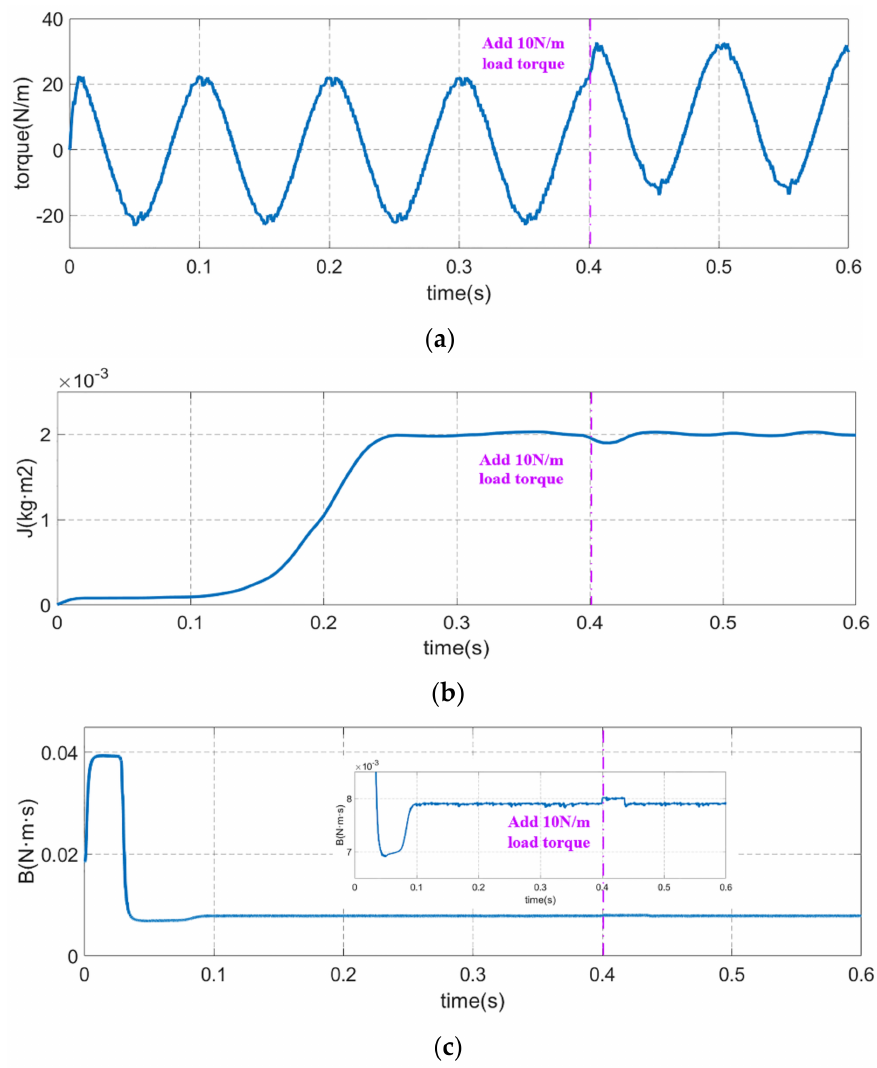
Figure 11. The anti-disturbance performance of the inertia and friction coefficient identification results: ( a ) Motor speed. ( b ) Moment of inertia. ( c ) Viscous friction